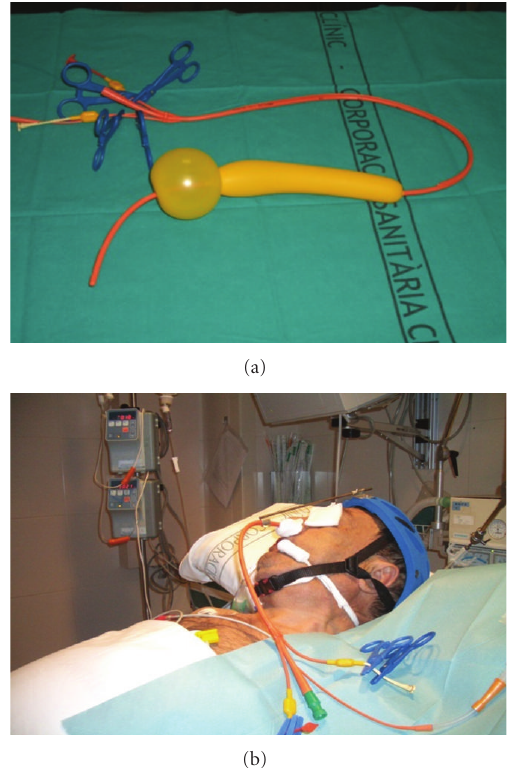
Figure 2: (a) Four lumen Sengstaken-Blakemore (Minnesota) tube. The gastric balloon is inflated with 150–200 mL of air and then pulled on the cardioesophageal junction and secured by di ff erent options such as a specially designed helmet (b). The esophageal balloon is inflated with air to a pressure of 40–50 mmHg. As shown, the tube has four lumen: the gastric and esophageal balloon inflati- on ports and the gastric and esophageal aspiration